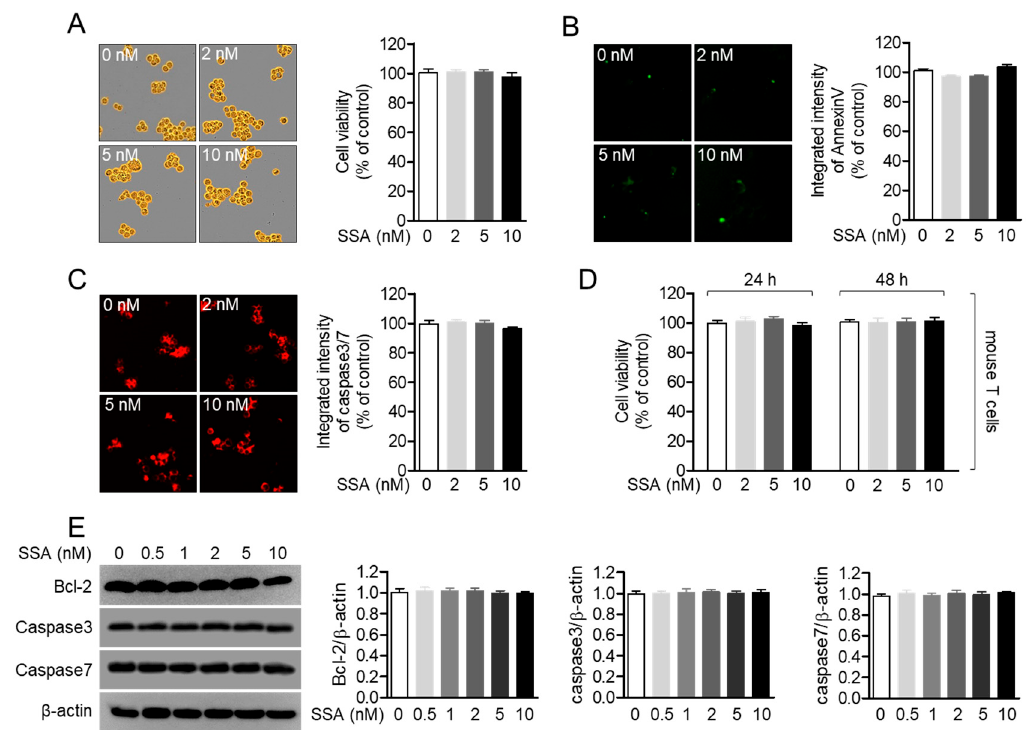
Figure 3. Treatment with 10 nM salinosporamide A is not cytotoxic to T cells. ( A – C ) DIC images ( A ), the expression of AnnexinV ( B ), or caspase3/7 ( C ) in Jurkat T cells obtained from the IncuCyte imaging system after incubation with the indicated concentration of salinosporamide A (0–10 nM) for 24 h. ( D ) Mouse CD4 + T cells were treated with the indicated concentration of salinosporamide A (0–10 nM) for 24 h or 48 h. After incubation, cell viability was measured by MTT assay. ( E ) Expression levels of the indicated proteins were detected by western blot analysis of Jurkat T cells treated with the indicated concentration of salinosporamide A (0–10 nM) for 24 h. The mean value of three experiments ± SEM is presented.